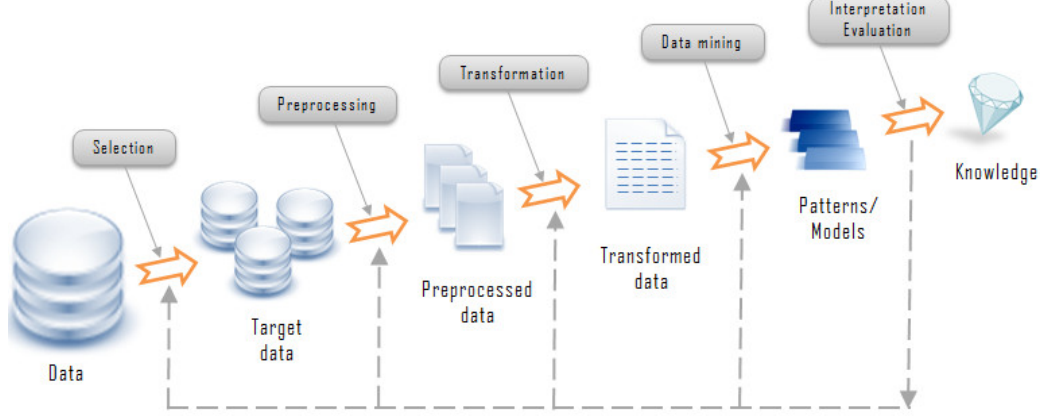
Figure 1. The knowledge discovery in databases (KDD) process (adapted from [7]).